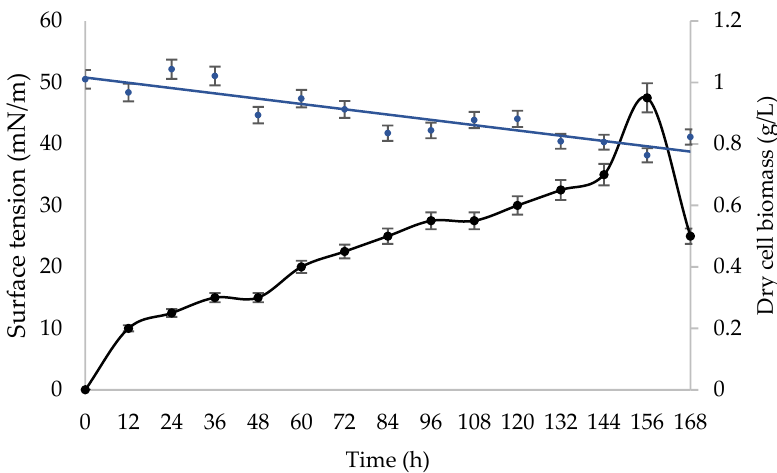
Figure 2. Cell biomass and surface activity profile of Bacillus sp. HIP3 when cultivated in MSM with 2% ( v / v ) UCO as a carbon source at 30 °C and 200 rpm for biosurfactant production.